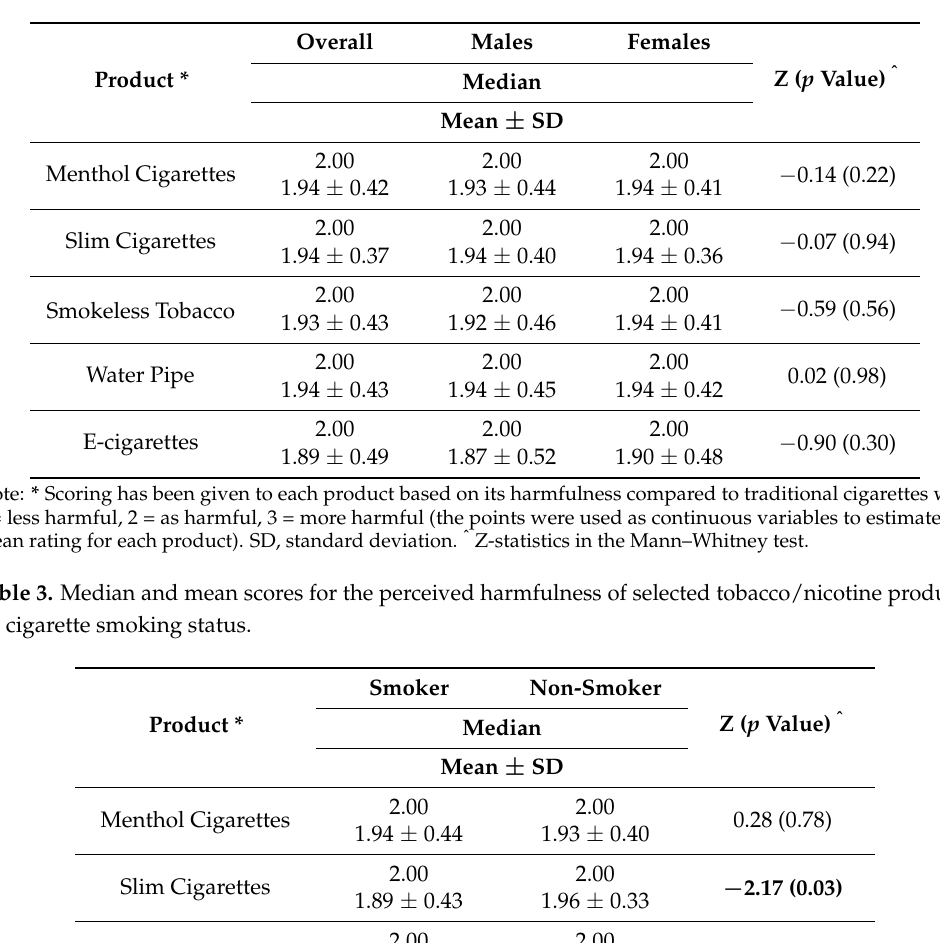
Table 2. Median and mean scores for the perceived harmfulness of selected tobacco/nicotine products by